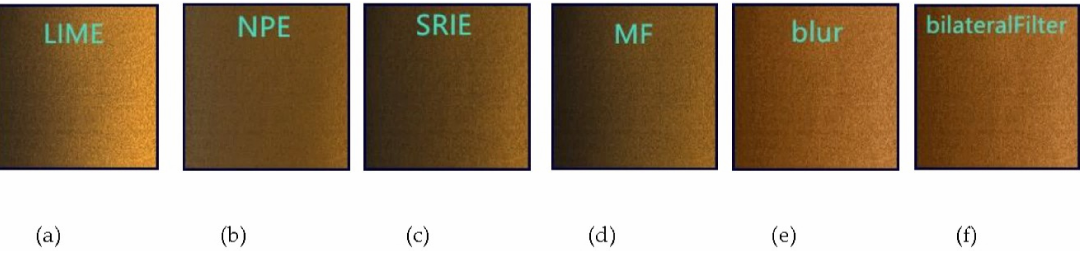
Figure 12. Side-scan sonar images enhanced using ( a ) LIME, ( b ) NPE, ( c ) SRIE, ( d ) MF, and our method with ( e ) mean filtering, and ( f ) bilateral filtering.